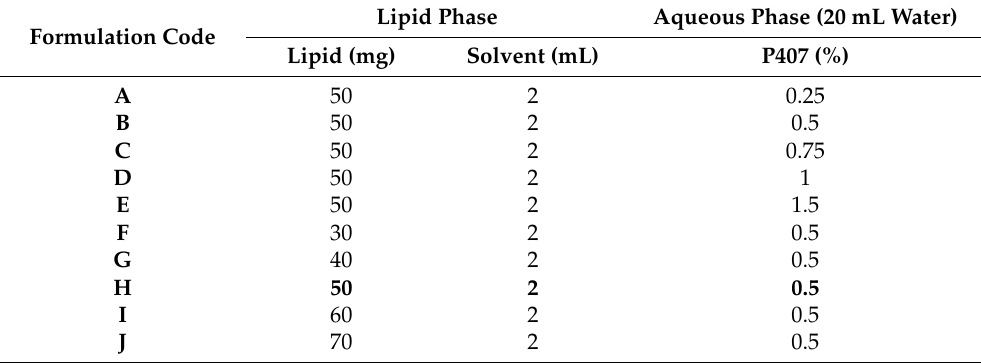
Table 1. Formulation of SLNs using HPH technique. Formulation